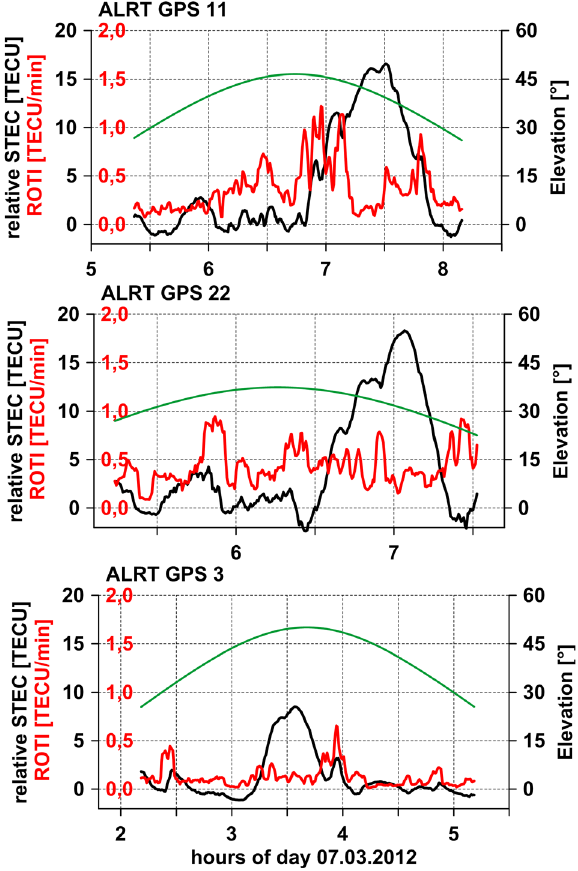
Fig. 5. Relative STEC and ROTI values for three arcs of ALRT data: satellite 11 (top panel), satellite 22 (middle panel) and satellite 3 (bottom panel),